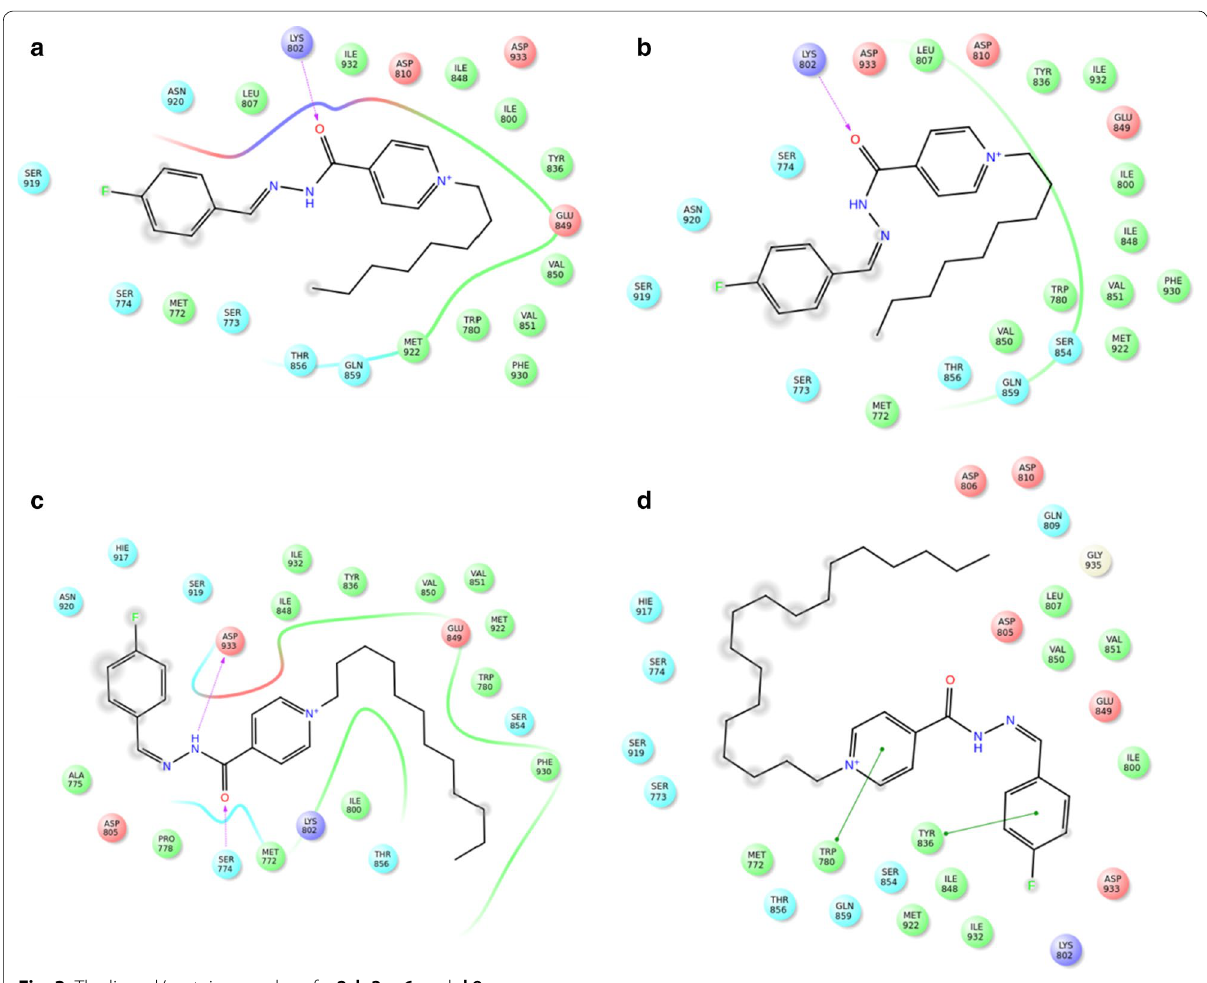
Fig. 3 The ligand/protein complex of a 2 , b 3 , c 6 , and d 9